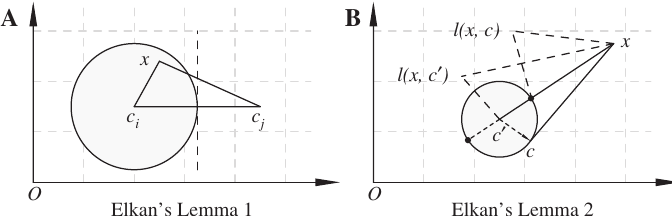
Figure 7. Applying the Triangle Inequality.